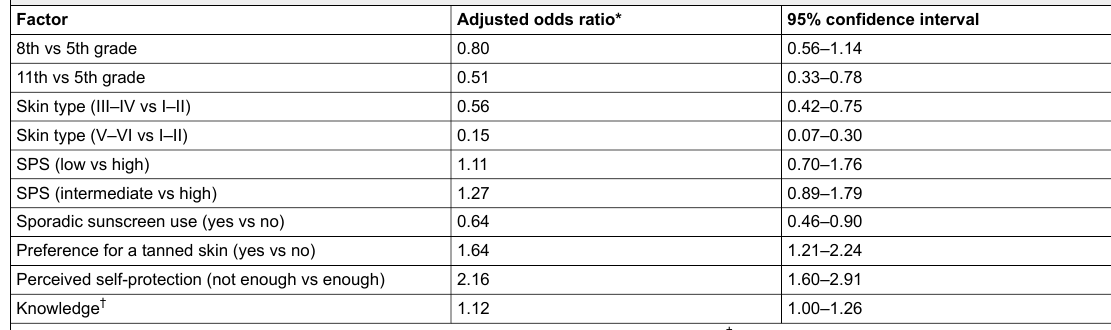
Table 3 : Multivariate logistic regression analysis for the occurrence of at least two sunburns.